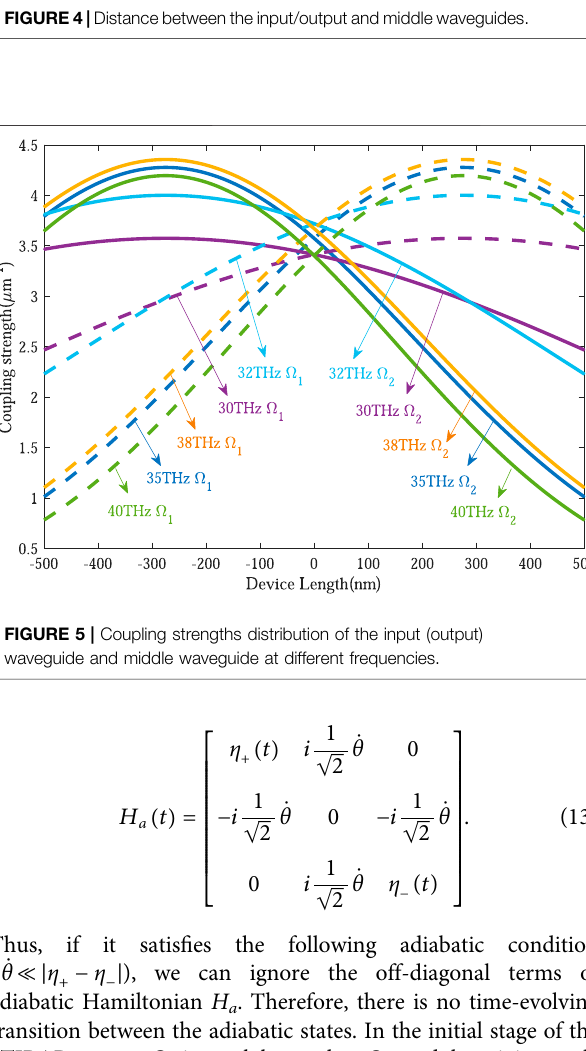
Frontiers in Physics |